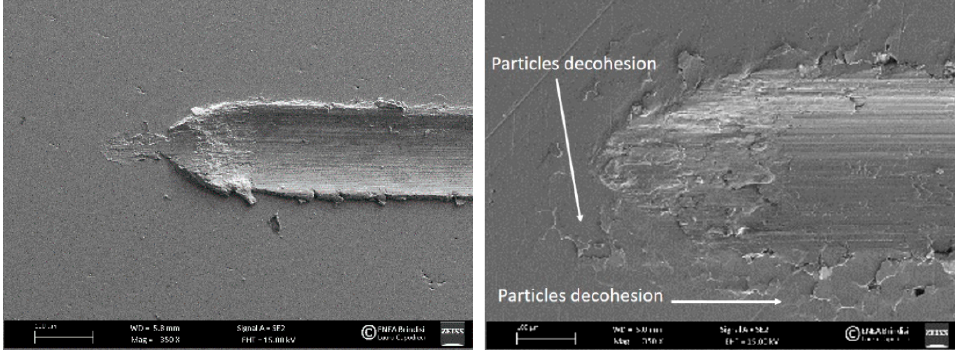
7 of 13 Figure 6. Individuation of critical loads from the scratch tracks in the locations corresponding to the critical load 1 ( a ), load 2 ( b ) and load 3 ( c ). By performing the scratch test through the application of a progressive load, it is pos- sible to observe a consecutive series of incisions in the coating as the load increases; the final event usually corresponds to the total delamination of the coating. The critical load depends on the adhesion of the coating as well as on the surface damage mechanisms. In the present case, the first critical load corresponds to the formation of the first hair- line cracks inclined at 30–40° with respect to the track direction on the coating surface (Figure 6a). This is consistent with previously described deformation modes [28]. This first critical load is normally associated with the first damage mechanisms appearance due to the scratch of the indenter. The damage features appear inclined with respect to the scratch direction because at the beginning of the scratch, the scratch tangential load is predominant on the compression one. In fact, the fracture trend is a function of the elas- toplastic properties of the indented material, the geometry of the indenter and the applied load factors [29]. The moment the tool penetrates through the coating, a fracture of the material is generated and a fluctuation of the forces involved. As a matter of fact, inside the scratch groove, many parallel cracks are revealed. These cracks are formed as a conse- quence of the tensile stresses in front of the indenter during sliding. These microcracks’ densities tend to increase as the vertical load increases. Once compressive load increases, additional cracks appear in the scratch track as a consequence of the increased compressive stresses. This behaviour is indicated as the sec- ond critical load (Figure 6b). The absence of bending cracks reveals that the substrate is sufficiently stiff to absorb the mechanical load. Once macrocracks start to lead to the coat- ing delamination, the coating is believed to be subjected to the third critical load. The de- laminations are wing shaped because of the complex multiaxial stress fields acting on the material. Once the third critical load is reached, the coating is scraped with the appearance of many macrodamages on the surface (Figure 6c). It is well-known that the relationship be- tween the coating hardness and wear behaviour shows also that, by increasing the coating hardness, the worn behaviour shifts from scratches and abrasion type surfaces to steel debris adhering to the coatings. So, the wear resistance, directly related to the coatings hardness, increases. In particular, a parabolic relationship can be underlined between the